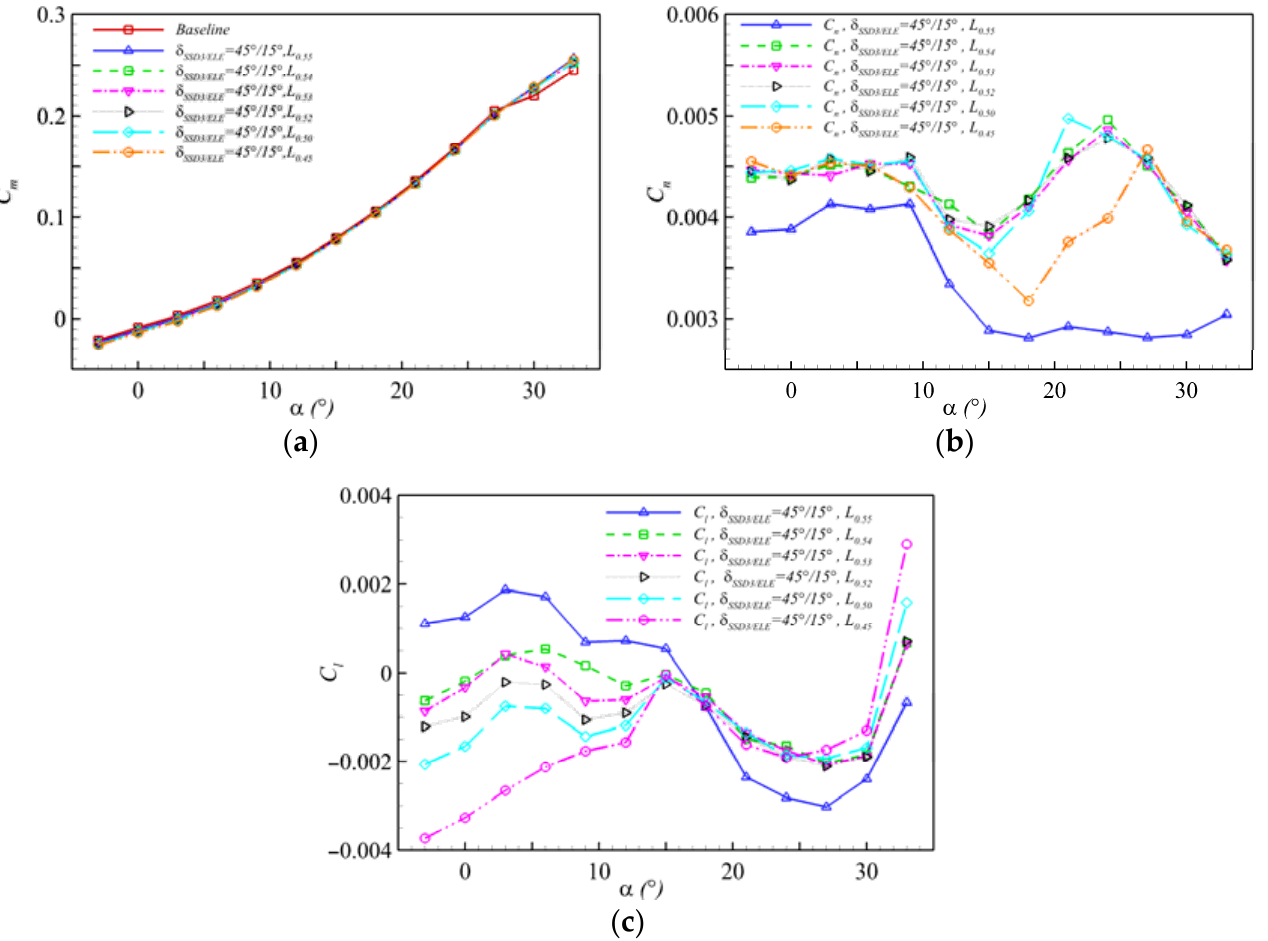
Figure 16. Control characteristics of the FCRs with different position of SSD3. Ma = 0.2, Re = 3.98 × 10 7 : ( a ) Pitching moment; ( b ) Yawing moment; ( c ) Rolling moment.